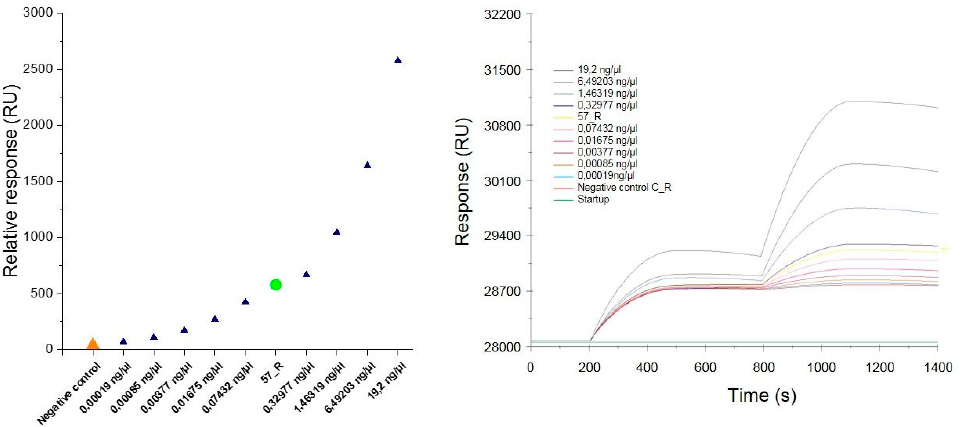
Figure 6. The relative SPR response against the concentration of the dilution of individual positive control samples and the DNA sample isolated from the roots of non-transgenic (C_R) and transgenic (57_R) tobacco ( A ). Overlay sensorgrams displaying the binding of the samples upon injection over the immobilized oligonucleotide probes followed by the enhancement of signal with the AuNPs-SA-I / II solution ( B ). Table 3. Results of SPR measurements for the dilutions of individual positive control samples